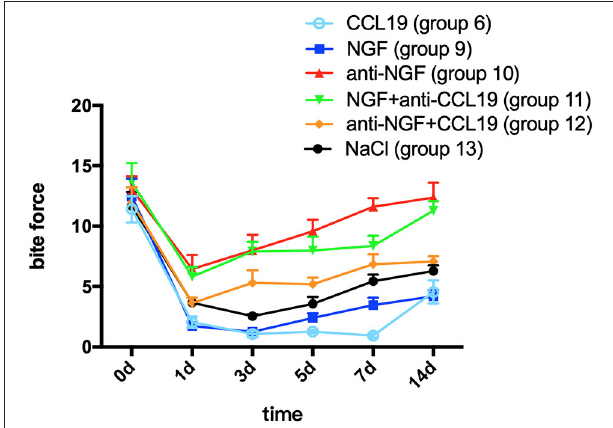
FIGURE 5 | Changes in pain expressed as the bite force modulated by NGF via CCL19 over time. (The statistical analysis results related to the image are shown in Table 3